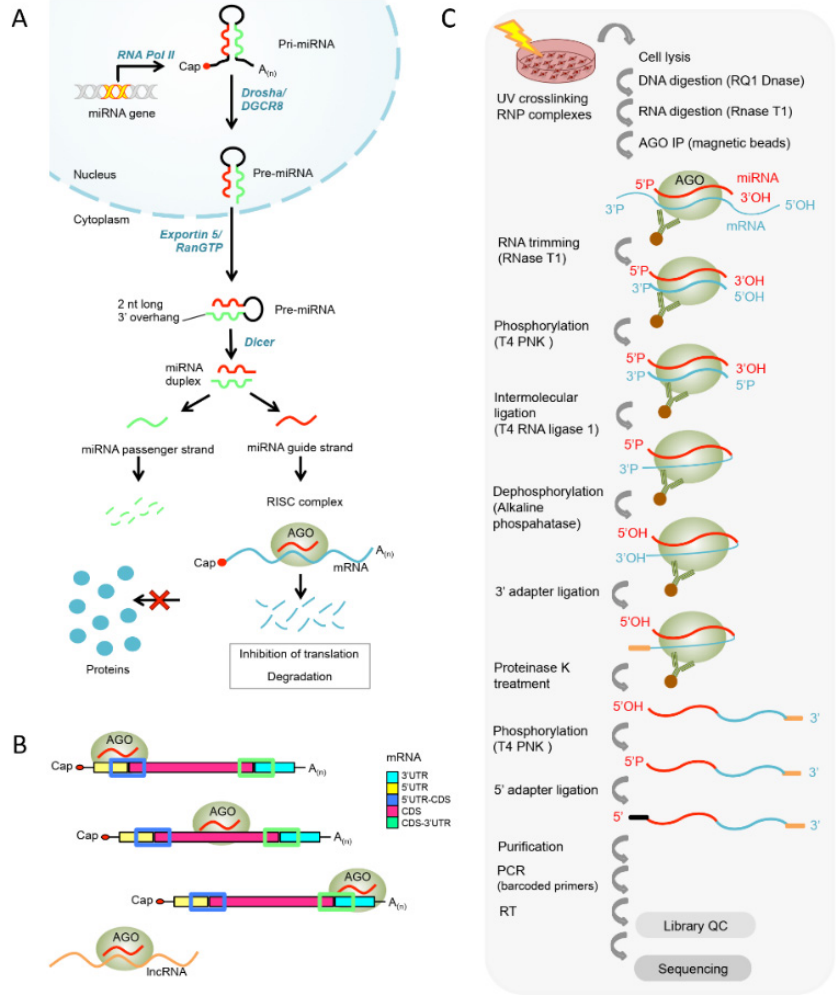
Figure 1. Canonical miRNA biogenesis pathway and overview of the qCLASH pipeline. ( A ) miRNAs are transcribed into a pri-miRNA by RNA polymerase II (RNA Pol II) in the nucleus. The pri-miRNA is processed by the endonuclease Drosha/DGCR8 into a pre-miRNA hairpin. The ~70 nt long pre- miRNA hairpin is exported via Exportin 5/Ran-GTP to the cytoplasm, where it is further processed by the endonuclease Dicer into a ~22 nt short miRNA duplex. One of the two miRNA strands is incorporated into the RNA-induced silencing complex (RISC) that is composed of Argonaute (AGO) and other proteins, which interact with the miRNA. Although both strands within the miRNA duplex can modulate gene expression, in most cases, the main strand is loaded onto the RISC, whereas the passenger strand is rapidly degraded due to its low half-life [25]. After binding of the miRNA to the target gene, the silencing machinery recruits the adaptor protein GW182 that directly interacts with the poly A binding protein (PABP), which in turn leads to the recruitment of the deadenylase complex, thus facilitating poly A tail shortening and the inhibition of translation initiation. Once the poly A tail is shortened, the mRNA is decapped and the destabilized target mRNA molecule is degraded. ( B ) Possible miRNA binding sites on the mRNA, namely, 5 (cid:48) and 3 (cid:48) untranslated regions (5 (cid:48) UTR and 3 (cid:48) UTR), coding DNA sequence (CDS), 5 (cid:48) -UTR-CDS, and CDS-3 (cid:48) UTR. Next to the mRNA, miRNAs have the potential to bind to lncRNAs and any other RNA molecules. ( C ) In the quick cross-linking ligation and sequencing of hybrids (qCLASH) protocol, RNA-protein (RNP) complexes of interest are UV cross-linked in living cells. The protein of interest is purified by immunoprecipitation (in this case, AGO bound to the miRNA and the target gene). The two interacting RNA molecules (e.g., miRNA-mRNA) are physically bound to each other by intermolecular RNA-RNA ligation, followed by library preparation and